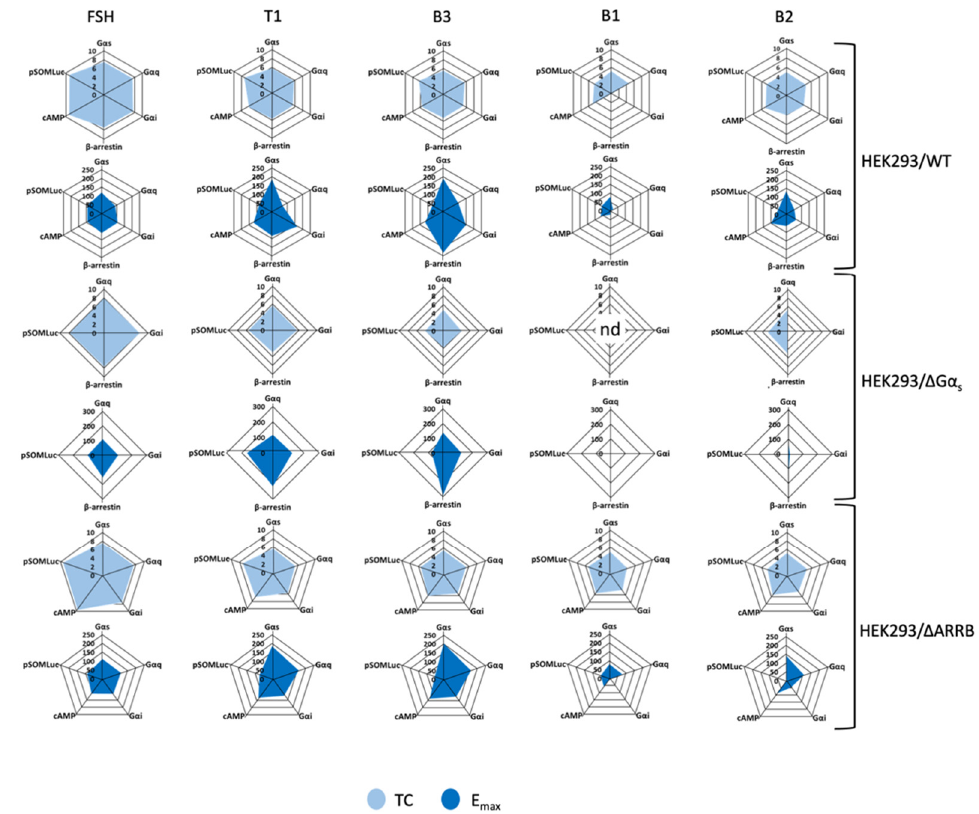
Figure 8. Radial graph representation of FSH and LMW ligand-induced transduction coefficients (TC) and maximal efficacies (Emax). Transduction coefficients and maximal efficacies were obtained after curve-fitting of FSH and LMW ligand-induced concentration/activity curves and are represented as radial graphs. Radius for TC is in logarithmic scale while radius for Emax is normalized, considering FSH maximal response as 100%, and is shown in linear scale. B1-induced transduction coefficients in HEK293/ Δ G α s were not identifiable, and the relative radial graph was labeled as “not determined” (nd).